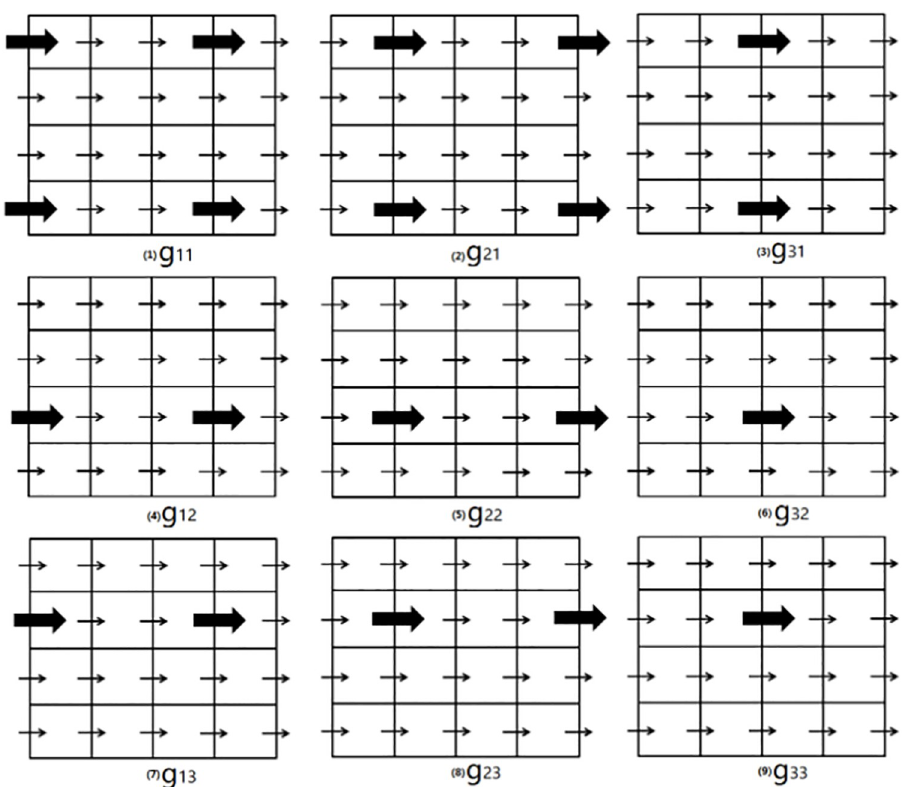
Fig 3. A two-dimensional sketch of the shifting. All the variables are discretized in the x -direction, which is represented by arrows. All the DVs are allocated to nine groups, which are represented by g group, the arrows allocated to it are in bold. g 21 is derived by shifting g 11 by one position in the positive x -direction (the right direction), and g 12 is derived by shifting g 11 by one position in the positive y -direction (the up direction). In each group, any pair of adjacent bold arrows has the other two arrows that are not in this group between them.